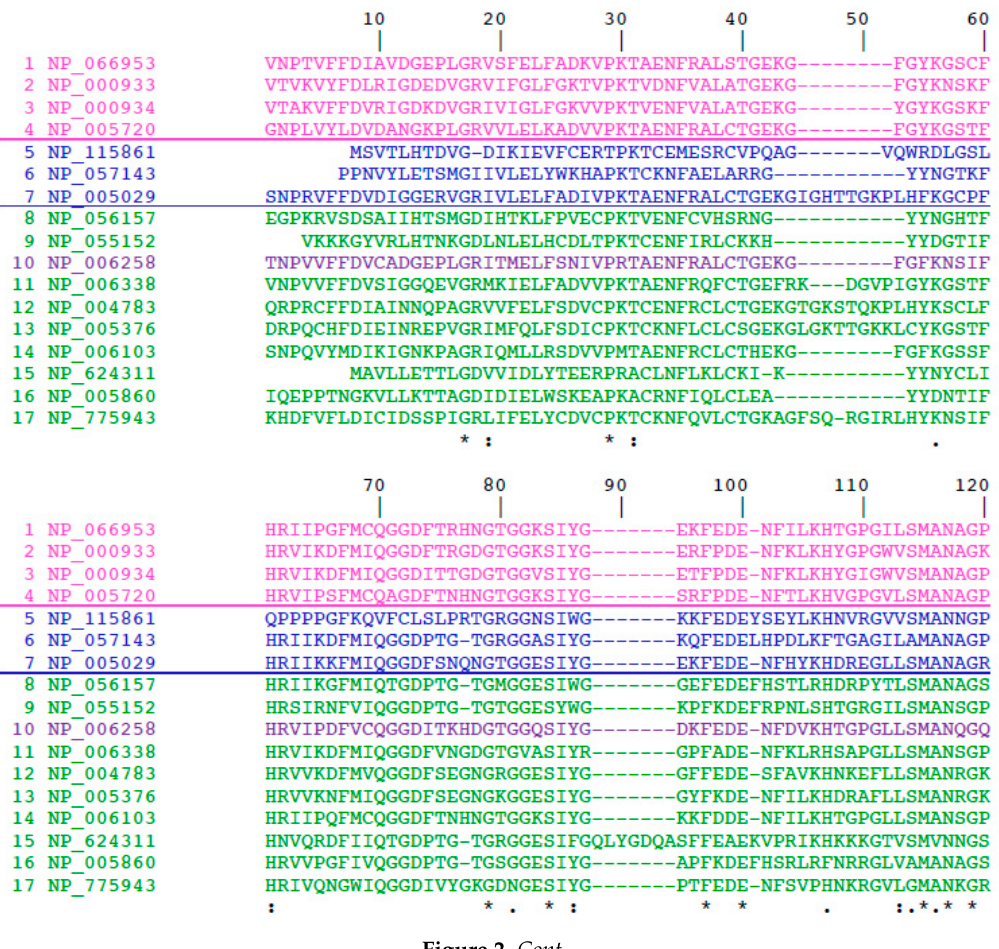
Figure 1. Matrix of human FK506-like binding domains (FKBDs) used for the construction of the heat map shown in Figure 3. 1— FKBP12a. 2—FKBP12b; 3—FKBP25; 4 and 5—first and second FKBDs in hFKBP52; 6 and 7 first and second FKBDs in hFKBP51; 8—FKBP36; 9—hFKBP38; 10—FKBP13; 11— FKBP encoded by the Fkbp7 gene; 12—FKBP encoded by Fkbp11 gene; 13—FKBP encoded by the Fkbp14 gene; 14 to 18, the FKBDs of hFKBP9; 19—22, the FKBDs in hFKBP10.